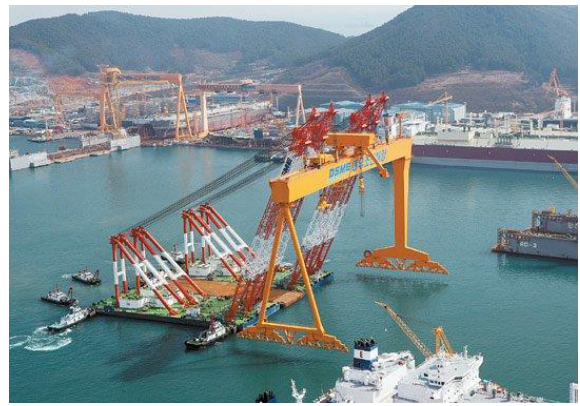
Figure 1. Motion control of barge ships using tugboats.